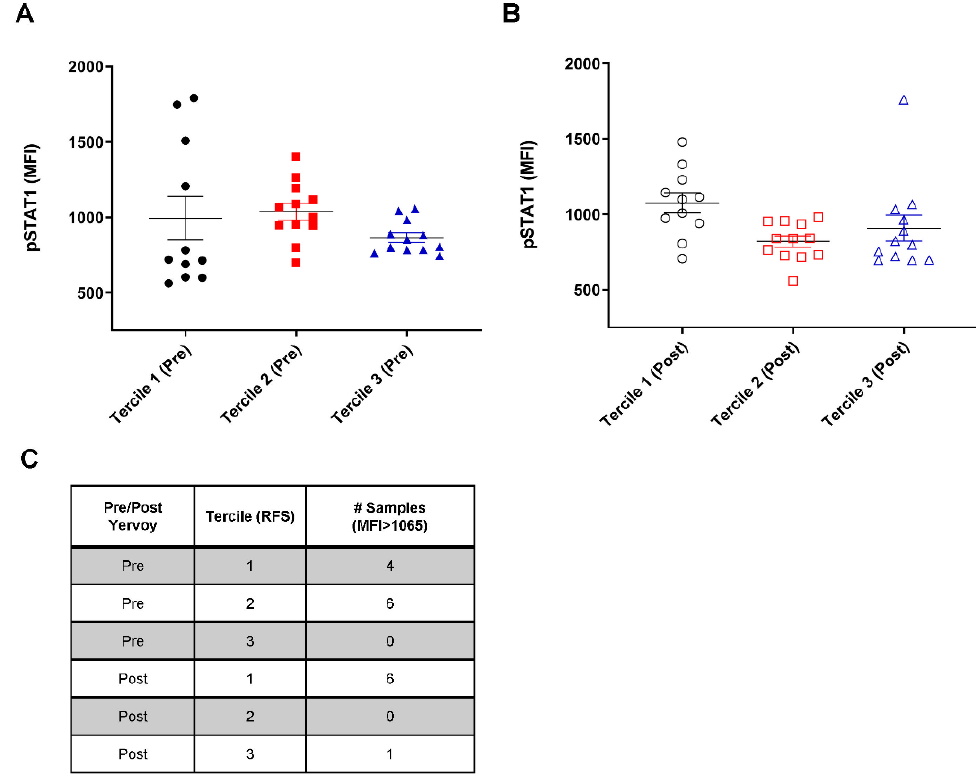
Figure 1. Peripheral blood mononuclear cells (PBMCs) from patients with long relapse-free survival (RFS) display a small variance in levels of phosphorylated STAT1 (pSTAT1). PBMC samples from patients were strati fi ed into RFS terciles before anti-CTLA-4 therapy. Tercile 1 represents the poor outcome, whereas Tercile 3 represents the favorable outcome following anti-CTLA-4 therapy. ( A ) pSTAT1 level measured before ipilimumab administration; ( B ) pSTAT1 level measured after 150 days of adjuvant therapy. Error bar showing ± standard error of the mean (SEM). Abbreviation: MFI, mean fl uorescence intensity. ( C ) Table of the number of samples with an MFI greater than 1065.